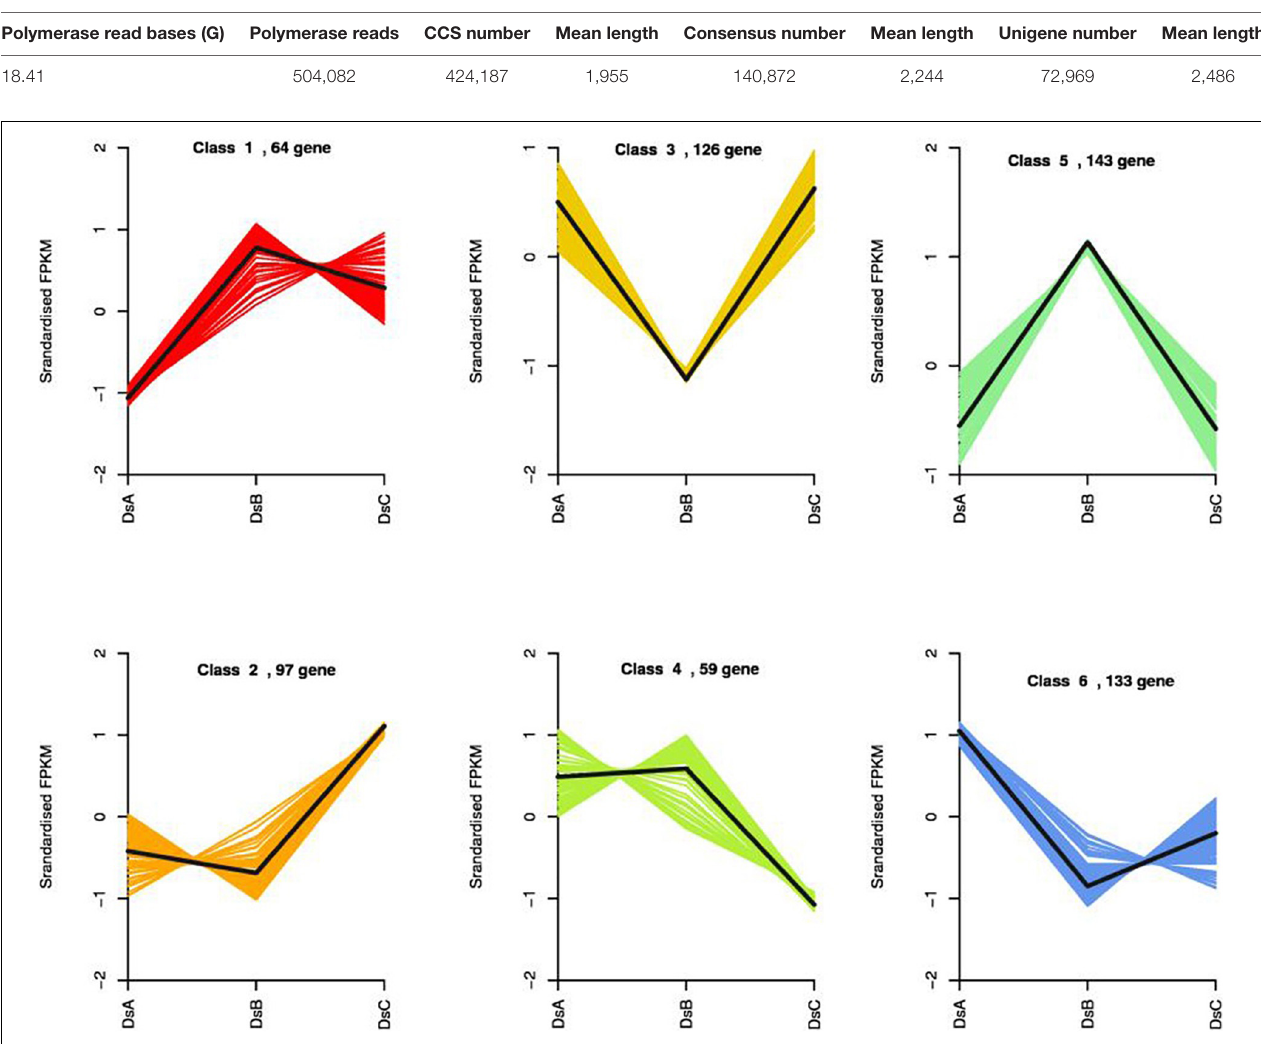
TABLE 1 | Summary of non-redundant transcriptional sequences.